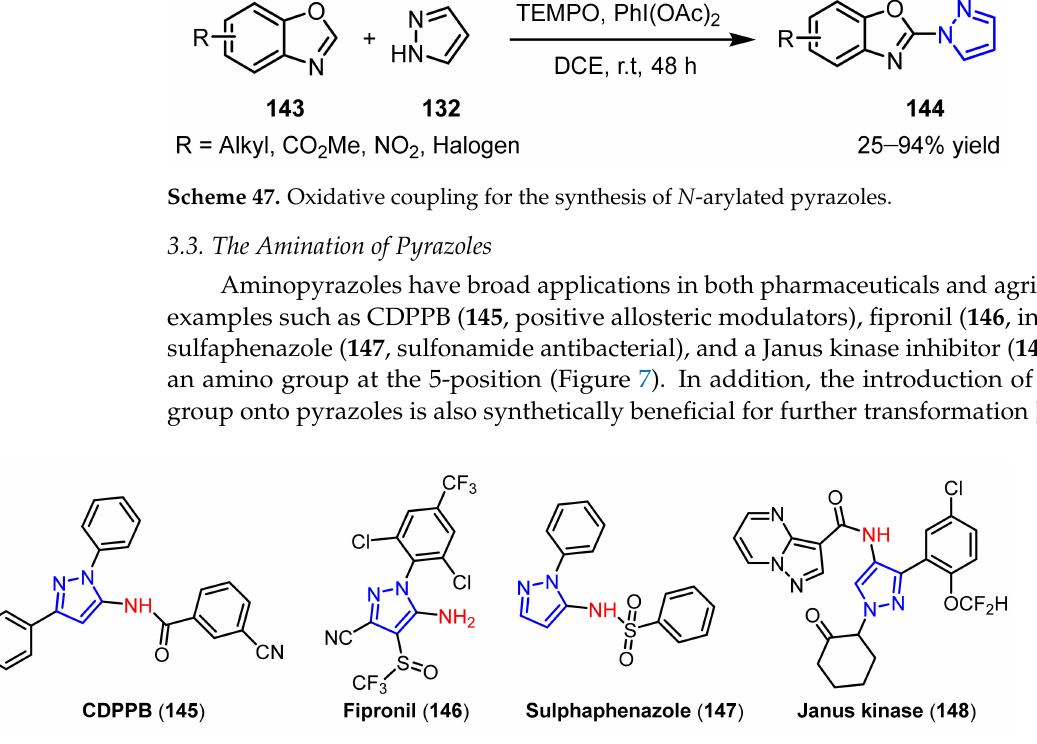
Figure 7. Bioactive